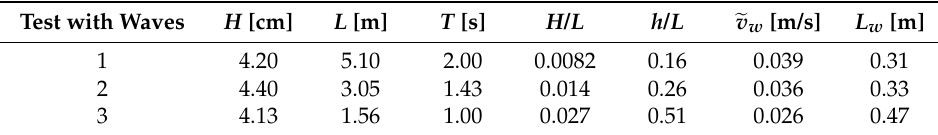
Table 1. Main characteristics of the jet configurations with